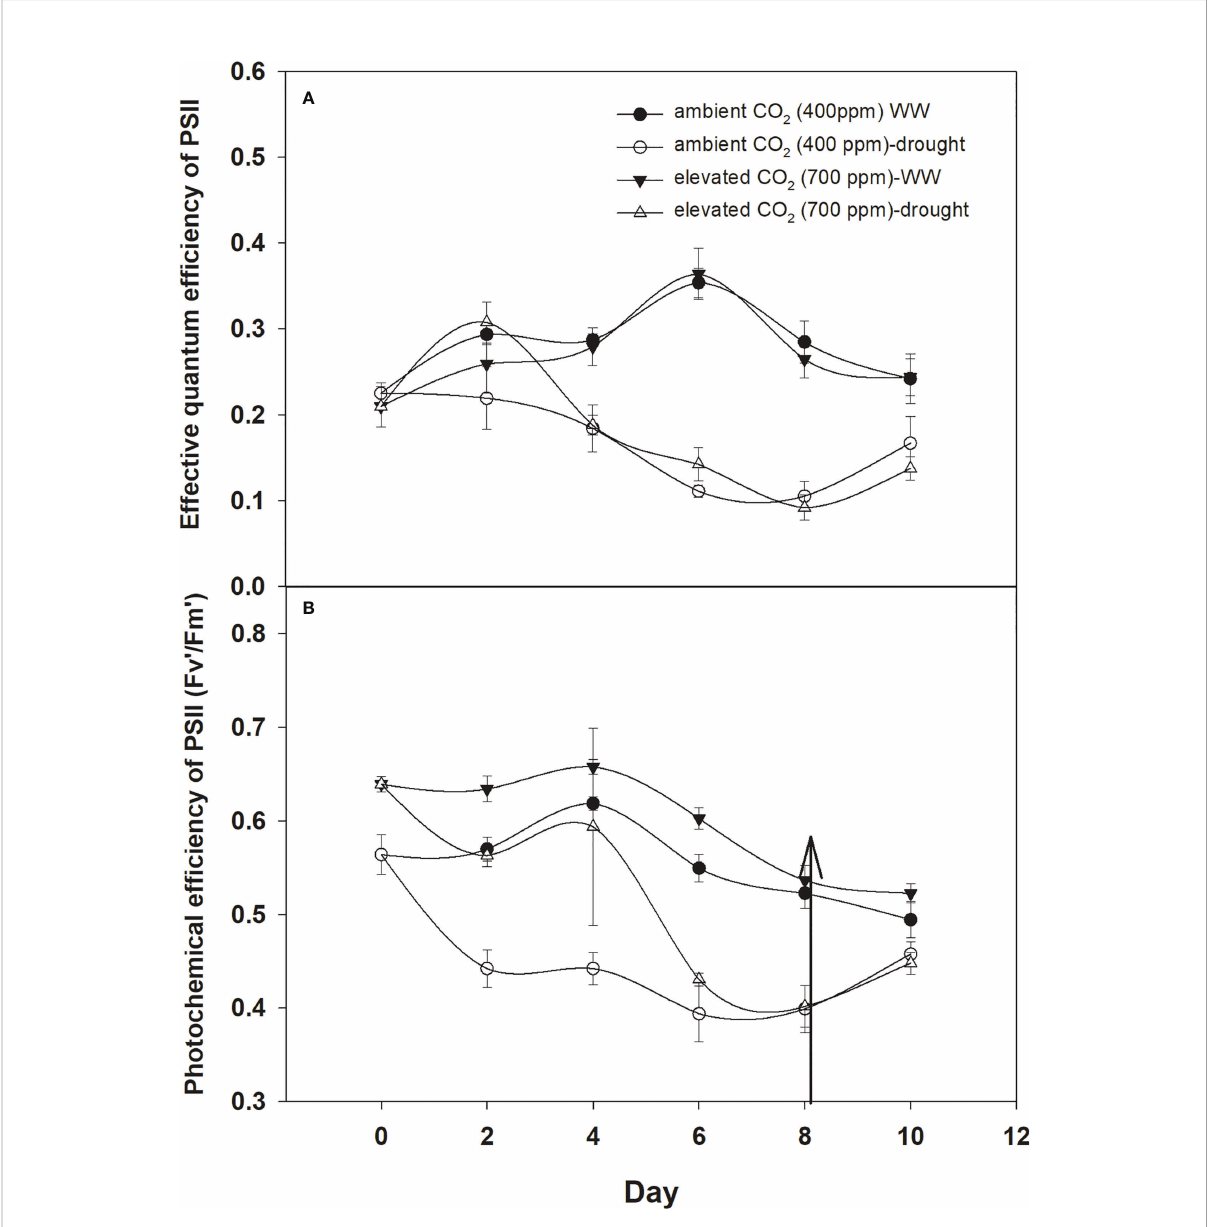
FIGURE 7 Effect of CO 2 concentrations and moisture conditions on (A) effective quantum ef fi ciency of PSII and (B) photochemical ef fi ciency of PSII of Datura stramonium . The vertical line on the data point represents the standard error of the mean and the vertical arrow line after Day 8 represents the addition of water in the drought treatments. WW,